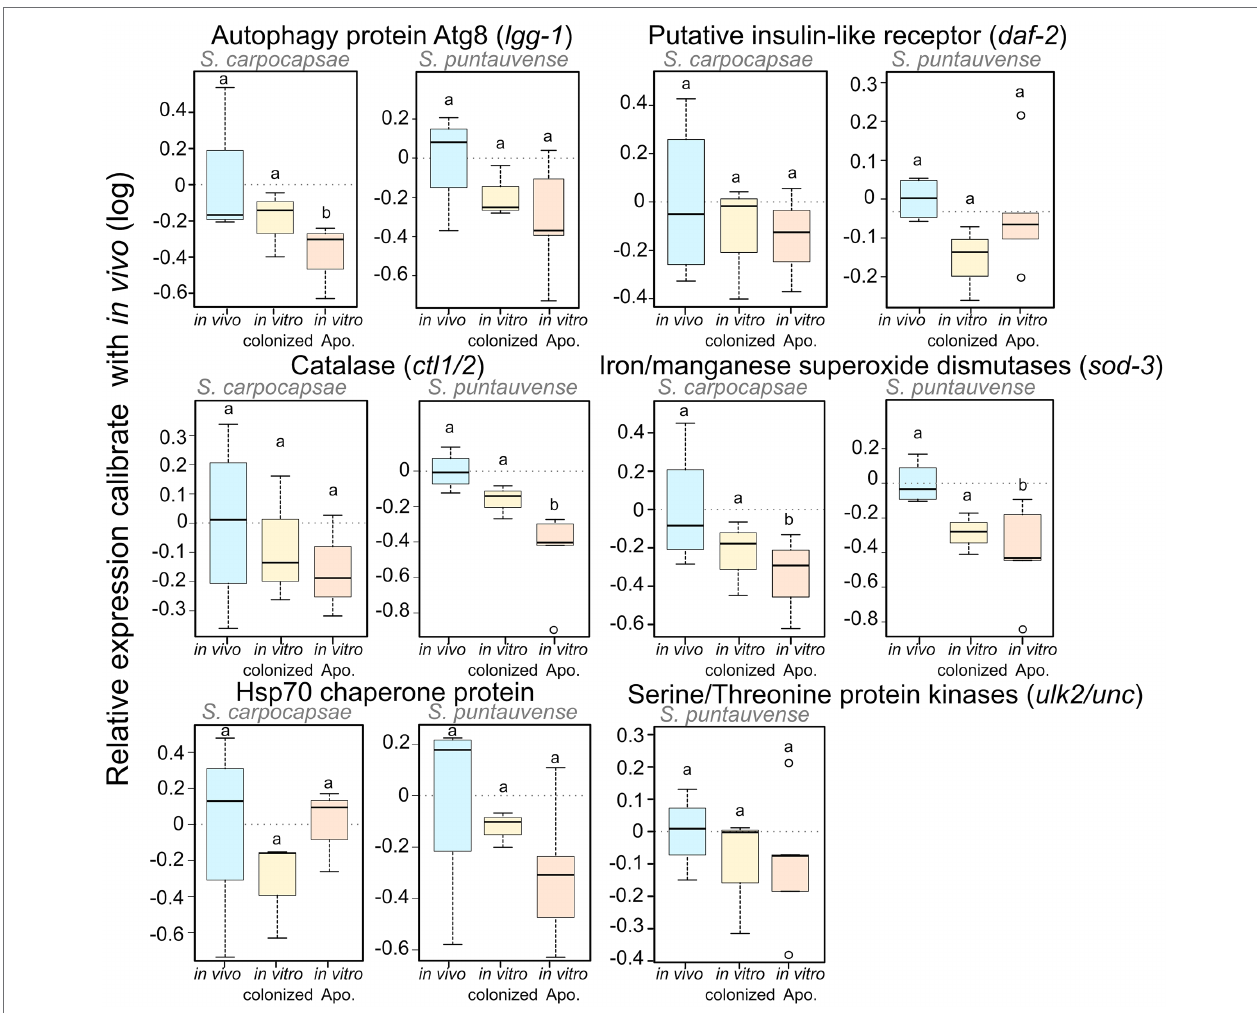
FIGURE 9 | Boxplot of the relative expression of six transcripts involved in longevity regulating pathway ( lgg-1 , daf-2 , ctl1/2 , sod-3 , hsp70 , and ulk2/unc ) using qRT-PCR. The relative expression was calculated using a modified Pfaffl model normalized with the two housekeeping genes, actin and MCM and calibrate with the value detected for the in vivo reared nematodes RNA. Boxplot present the log of the calculated relative expression. Differential expression was tested by either one way ANOVA associated with post-hoc Tukey’s HSD or the non-parametric Kruskal-Wallis rank sum associated with multiple pairwise comparisons using the Dunn’s test according to applicable condition. Bars labeled with the same letter are not significantly different from each other. See details of statistical test in Supplementary Table S5